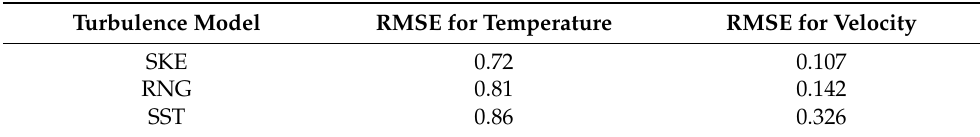
Table 6. RMSE of velocities and temperatures in different turbulence